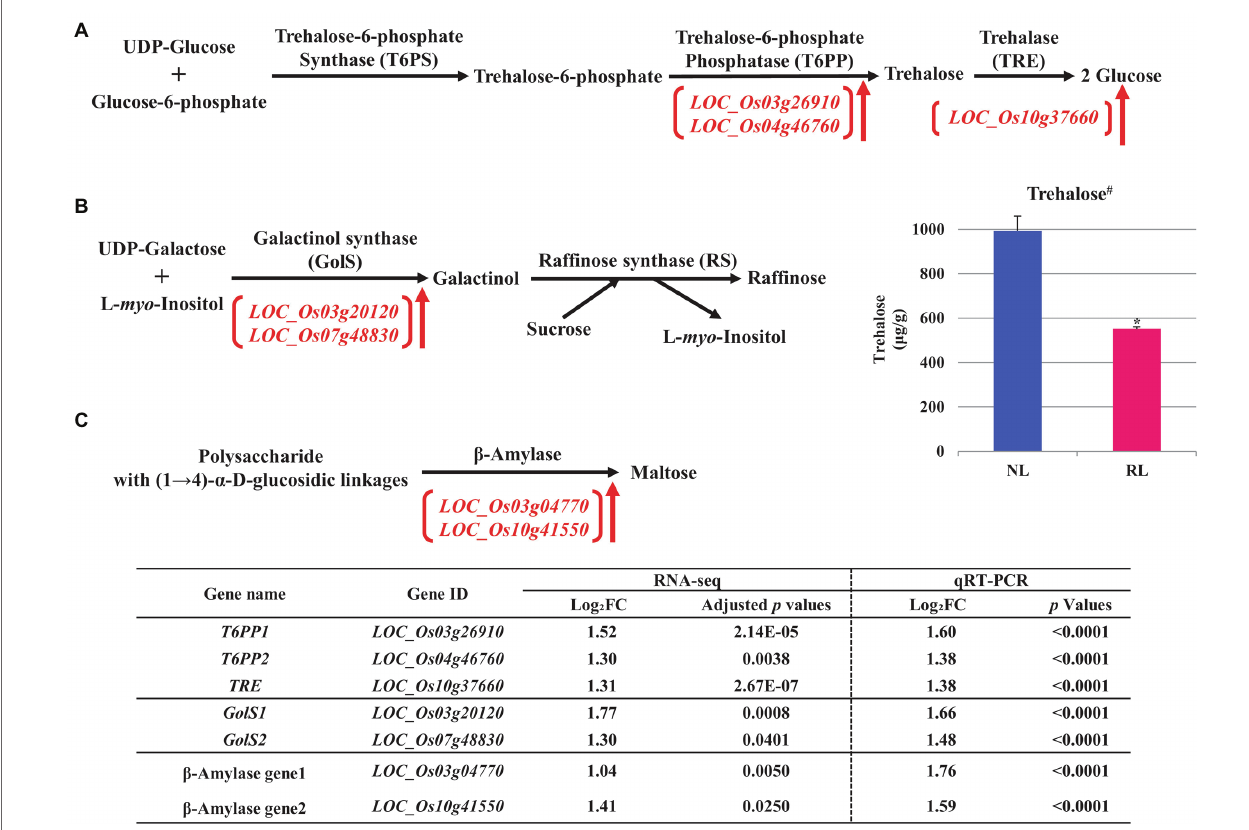
FIGURE 5 | Metabolic pathways of carbohydrates putatively related to salt stress in the developing seeds of Samgwang grown on reclaimed land (RL) and verification of upregulated genes through qRT-PCR. (A) Trehalose; (B) Raffinose; (C) Maltose. ↑ indicates upregulation. # indicates that trehalose was quantified in the brown rice of Samgwang grown on normal land (NL) and RL by LC/MS–MS. The Log 2 FC (FC, fold change) expresses the Log 2 value of a ratio of expression value of RL to that of NL (RL/NL), which was generated by RNA-seq and qRT-PCR, respectively, from the developing seeds of Samgwang. The significant difference for each dataset was determined by t -test. *0.01 < p <